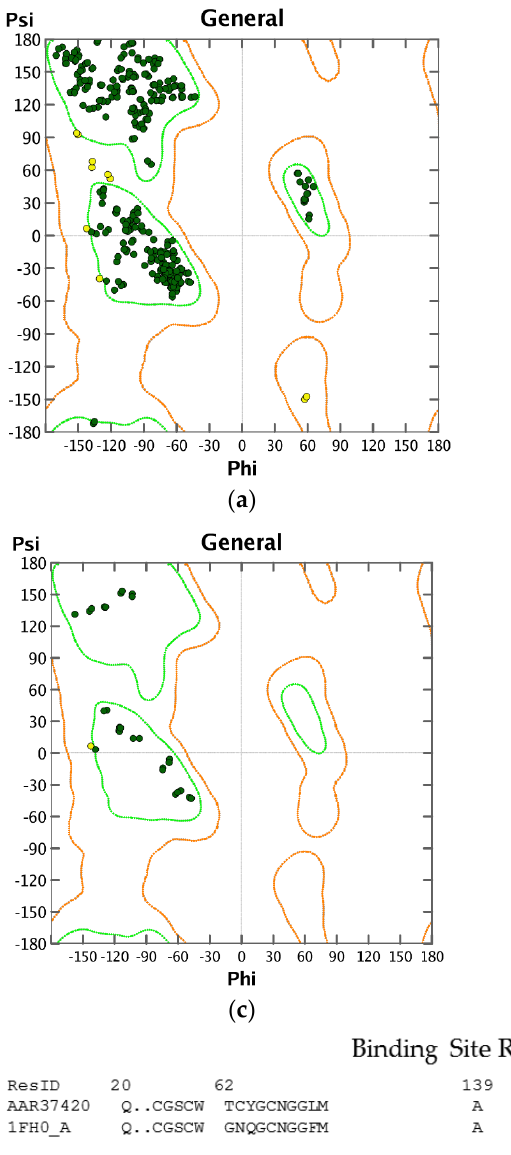
Figure 2. Ramachandran plots of cathepsin V-like protein structures: ( a ) human cathepsin V (HsCatV, PDB 1FH0 [26]); ( b ) homology model of Trichomonas vaginalis cathepsin L-like protein, TvCPCAC1; ( c ) binding site of HsCatV; ( d ) binding site of TvCPCAC1.